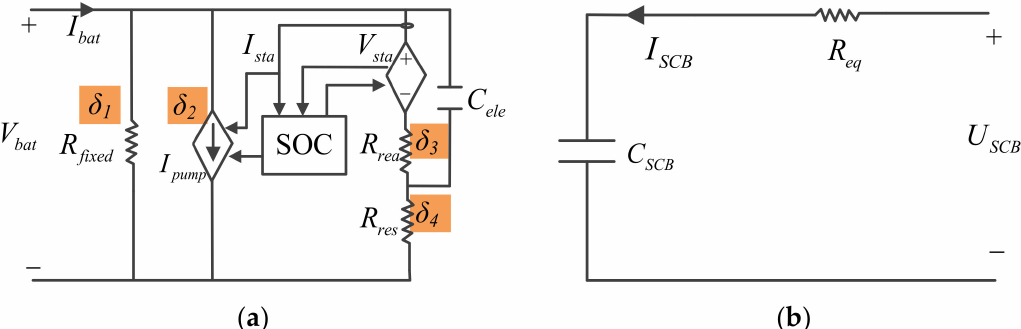
Figure 5. ( a ) Equivalent circuit model of VRB; ( b ) equivalent circuit model of